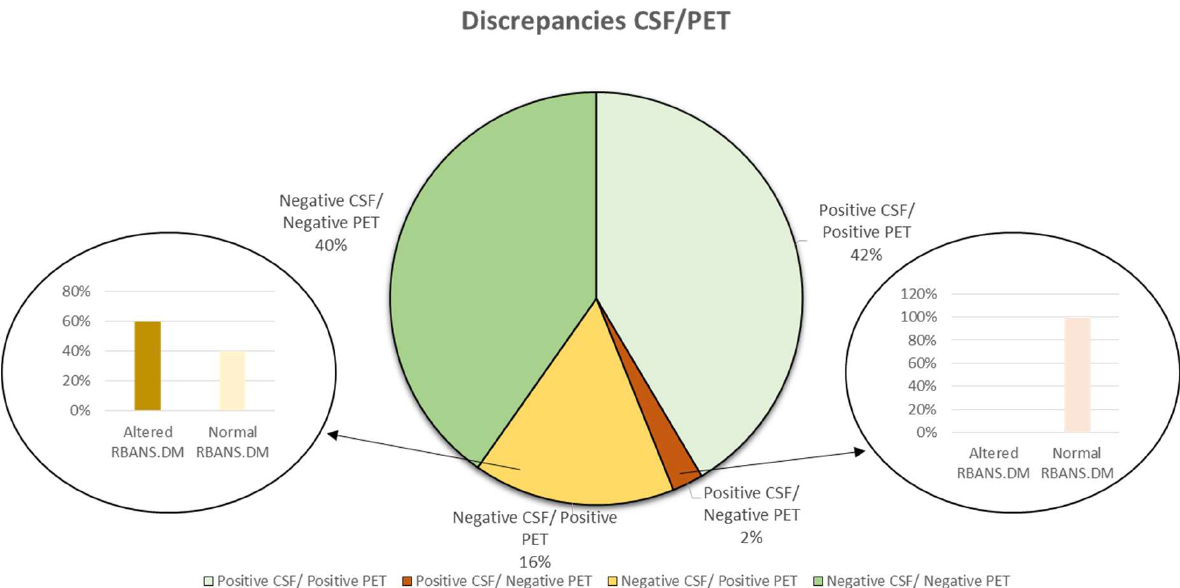
Figure 2. Representation of concordant and discordant results among CSF biomarkers and amyloid PET.